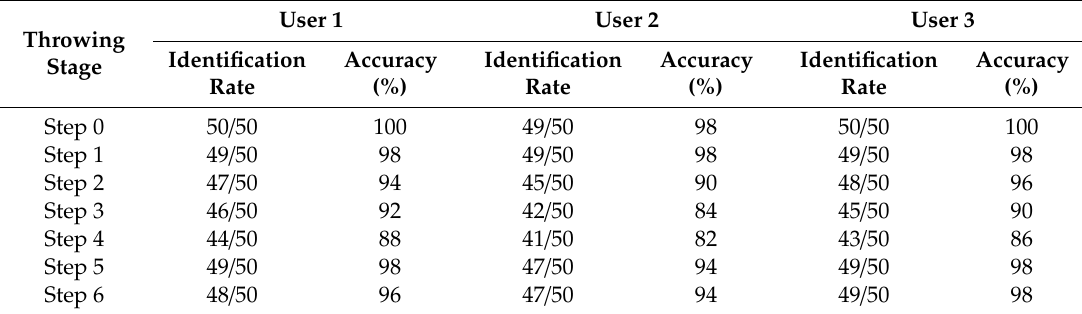
Table 4. Performance evaluation of throwing action